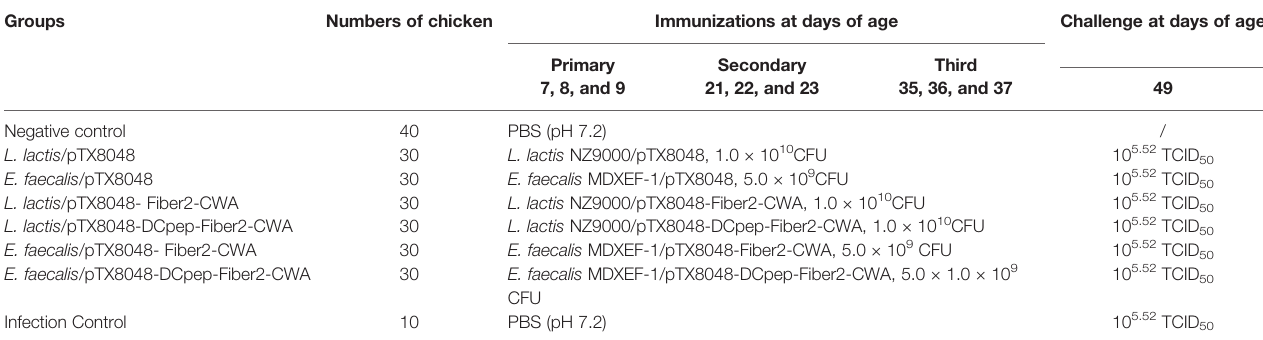
TABLE 1 | Experimental design of immunizations and challenge.